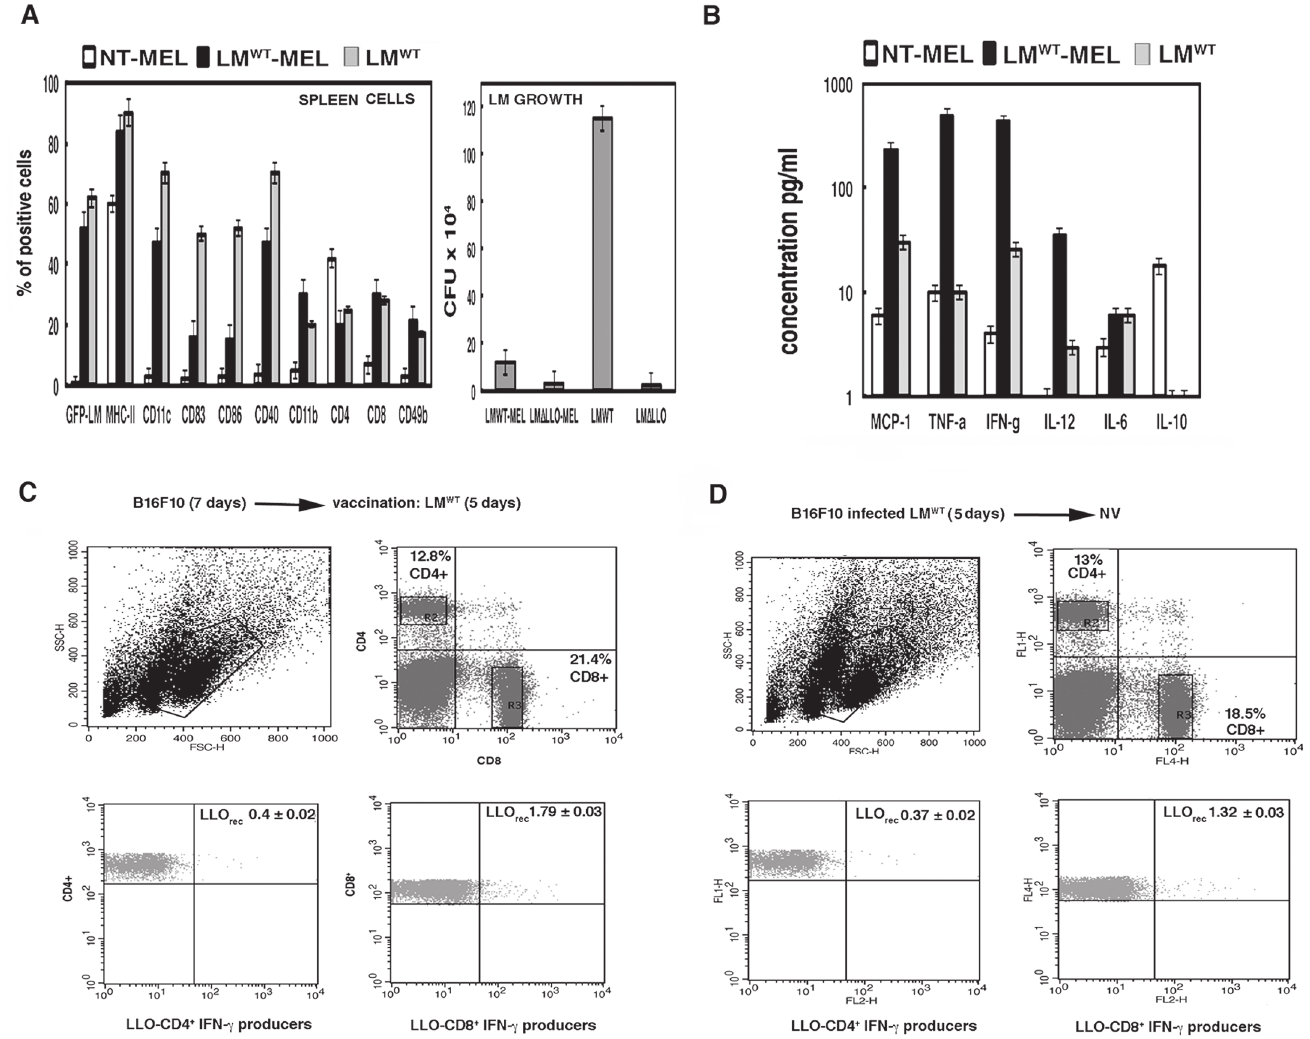
Fig 3. Efficiency of Listeria vaccination of melanoma is mediated by activation of LLO rec specific CD8 + T cells and inhibition of LLO rec specific CD4 + T cells. C57BL/6 female were inoculated i . p . with 5 x 10 5 B16F10/mice (n = 5) for 7 days and next injected i . p . or not (NT) with 5 x 10 3 bc/mice of GFP- LM WT strain for 3 additional days. Mice were bled and sacrificed. A , Immune cells plot (left) corresponds with spleens were homogenized and cell populations were analysed by FACS. Results were expressed as the mean of the percentages of positive cells ± SD. LM growth plot (right) corresponds with spleen homogenates examined for CFU in blood-agar plates. Results are expressed as CFU (mean ± SD) obtained with triplicate samples from three independent experiments ( P < 0,05). B , Levels of pro-inflammatory cytokines (MCP-1, TNF-alfa, IFN-gamma, IL-6, IL-10, IL-12) were analysed in sera of mice using the CBA kit (Becton Dickinson) by flow cytometry. Results were expressed as cytokine concentration (pg/ml of mean ± SD, P < 0,05). C , Spleen cells obtained from homogenates after inoculation with melanoma B16F10 (5 x 10 5 cells/mice) for 7 days and vaccination with LM WT for 5 days (LM WT -MEL). Cells were stimulated 5 h with recombinant LLO (0.1 μ g/ml) in the presence of brefeldin A for intracellular cytokine staining. LLO-stimulated spleen cell surface was stained for CD4 or CD8 and fixed and permeabilized using cytofix/cytoperm kit. Stimulated cells were surface stained for CD4 or CD8 using anti-CD4 + FITC- labeled or anti-CD8 + APC-labelled and data gated to include histograms show the percentages of LLO-CD4 + and IFN-gamma producers (lower left) and LLO- CD8 + and IFN-gamma producers (lower right) (R2 and R3 gates). Experiments were performed in triplicate and results are expressed as the mean ± SD ( p < 0.05). D , Spleen cells obtained from homogenates after inoculation with melanoma B16F10 pre-infected with LM WT (5 x 10 5 cells/mice) for 7 days. Cells were stimulated 5 h with recombinant LLO (0.1 μ g/ml) in the presence of brefeldin A for intracellular cytokine staining. Procedures were performed as in C and results expressed as the mean ± SD ( p <